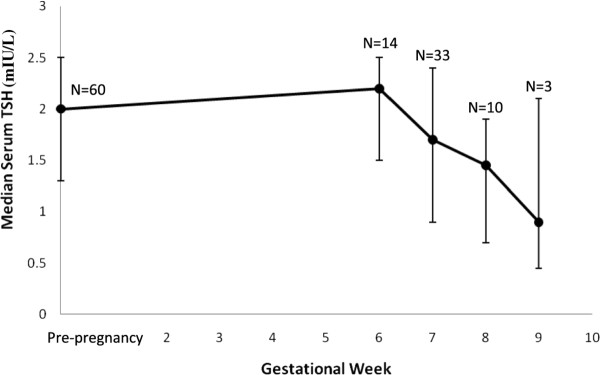
Periconception changes in TSH. Median (with interquartile range) serum TSH concentrations (mIU/L) are shown in the 60 study participants across the preconception and early pregnancy time frame defined by our study (< 10 weeks). Pre-pregnancy values are presented at 0 weeks gestation.